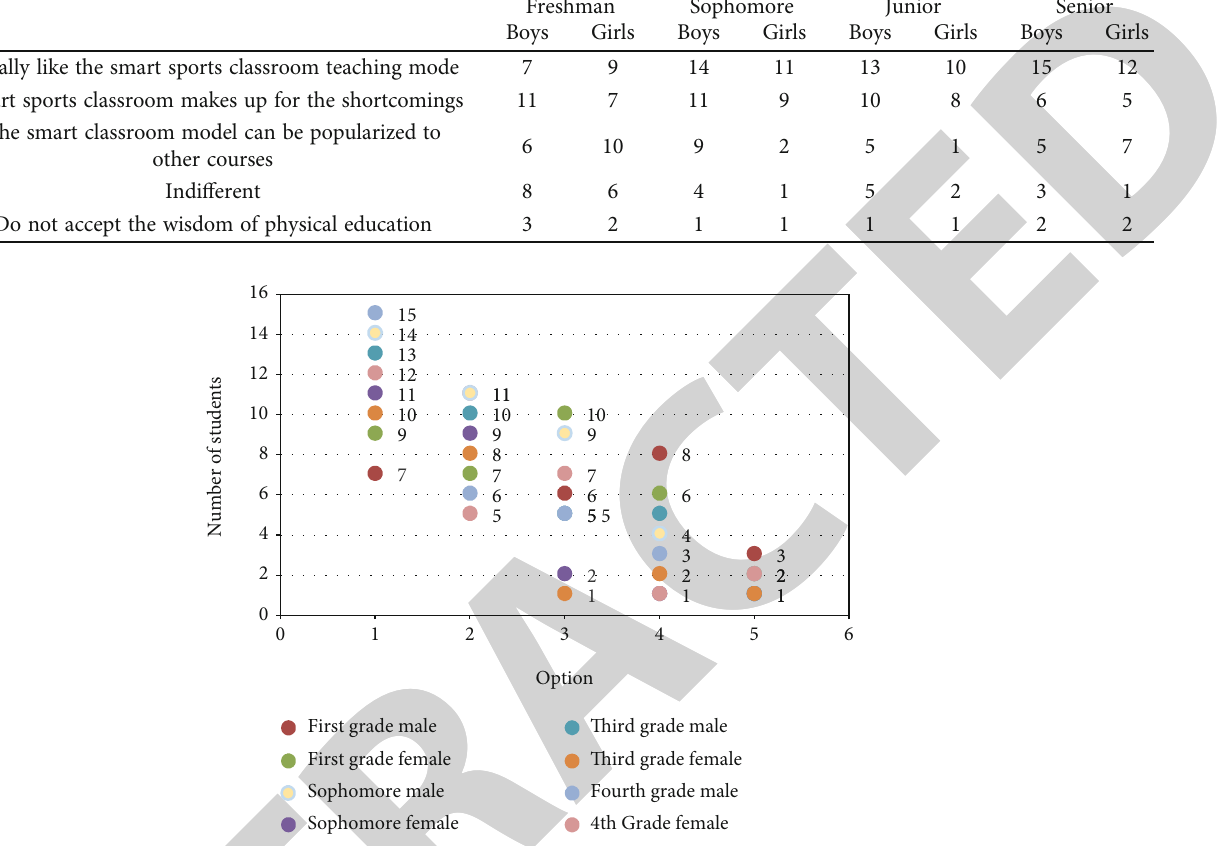
Figure 4: Students ’ recognition attitude towards smart sports classroom teaching mode. Table 5: Students ’ views on the design of learning activities in smart sports